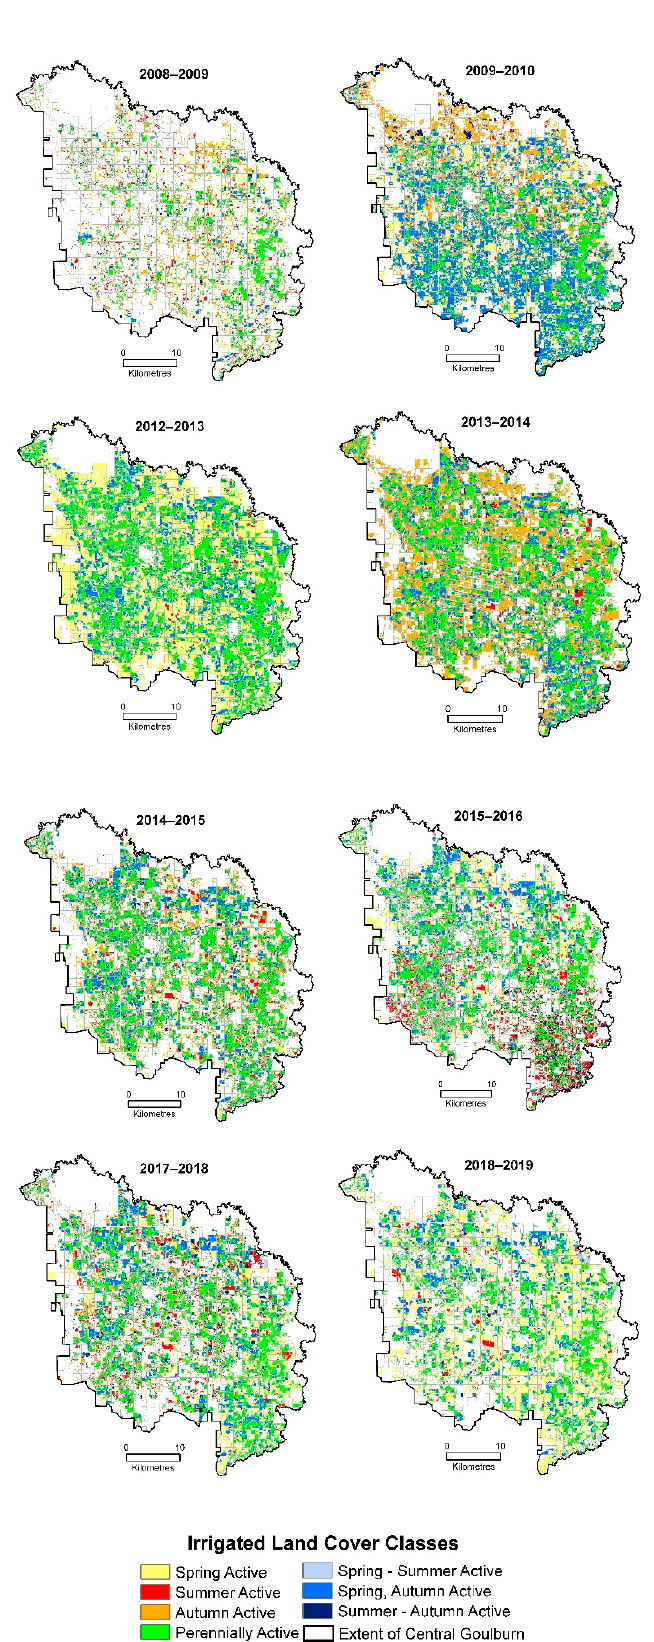
Figure 6. Maps of irrigated land cover in the Central ‐ Goulburn region from 2008–2009 to 2018–2019.